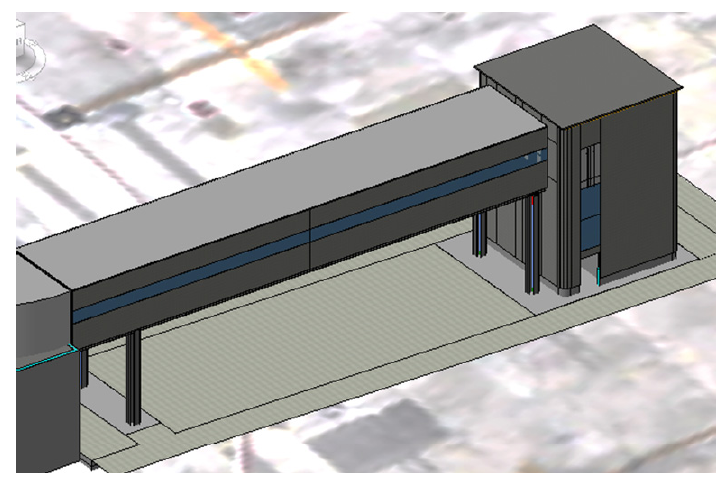
Figure 6. Architectural finishing model.